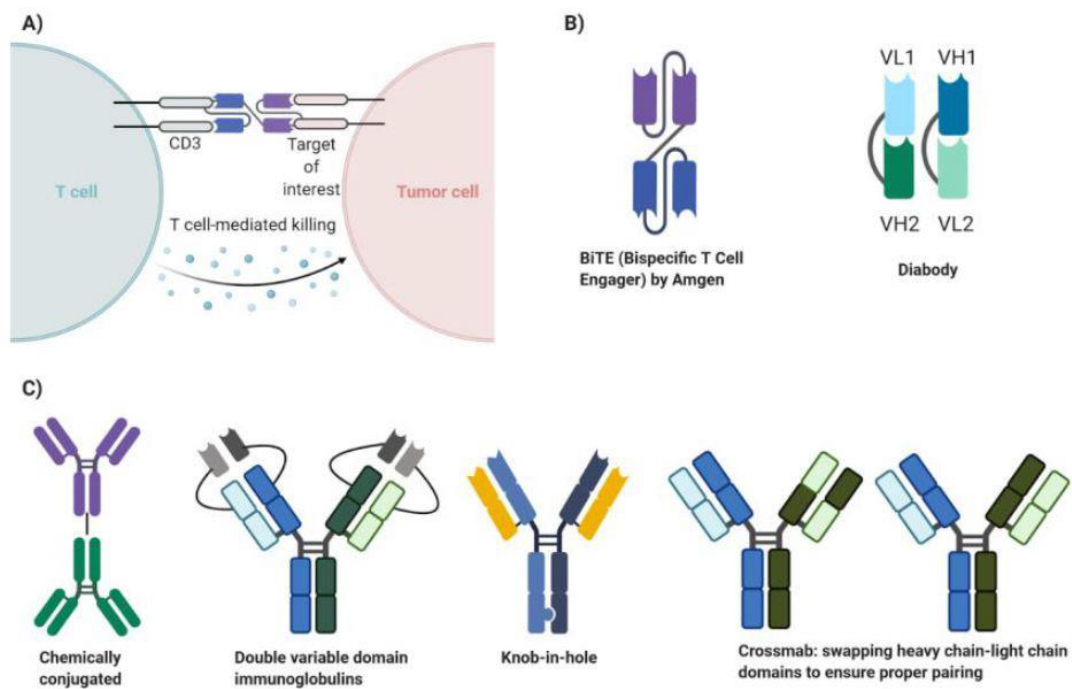
Figure 3. Bispecific antibodies. Bispecific antibodies (BsAbs) bind to the tumor target of interest and induce T cell activation, localization to tumor, and polyclonal proliferation by simultaneous interaction with the T cell’s CD3 domain (A). The bispecific antibody’s function arises from its ability to bind two separate antigens ( A ). Various bispecific antibody structures exist as illustrated ( B , C ). Part A of the figure adapted from “Bispecific Antibody Design”, by BioRender.com (2021). Retrieved from https://app.biorender.com/biorender-templates (accessed on 28 February